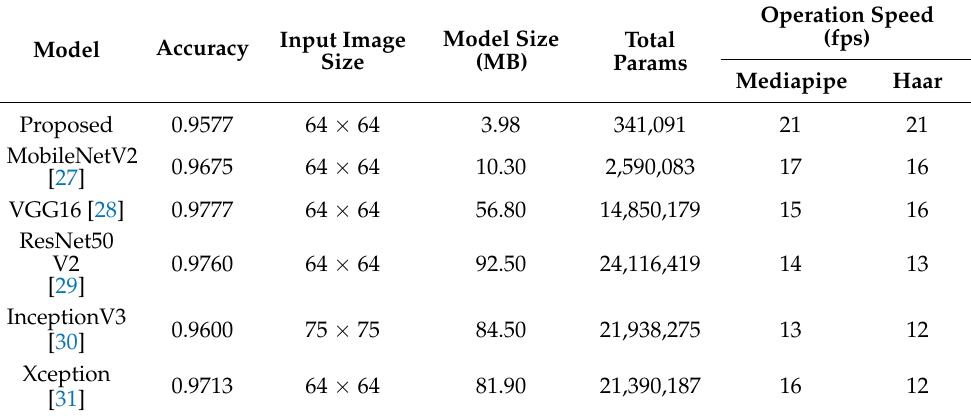
Table 4. Comparison of the proposed S-CNN with fine-tuned off-the-shelf CNNs.